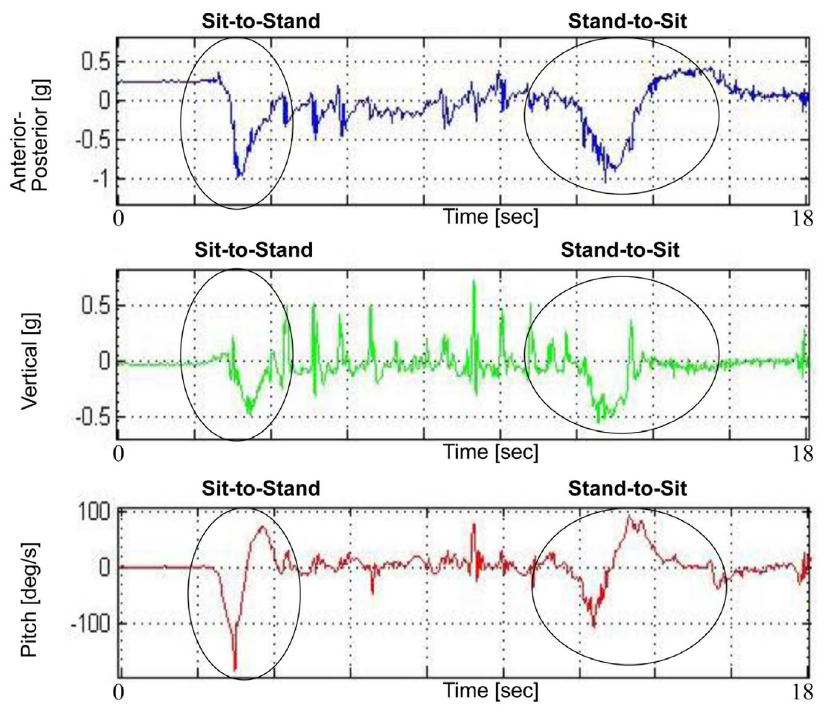
Figure 1. Transition components. Transition components derived from the anterior-posterior, vertical, and pitch axes.